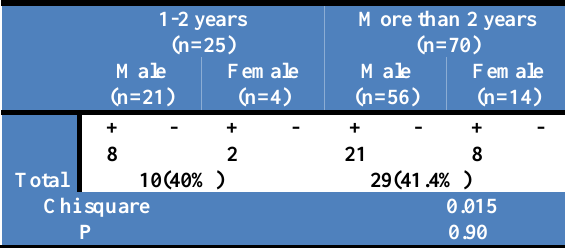
Table, 3: Number of positive isolates of E. coli O157: H7 in urine samples of cattle according to the age and gender.